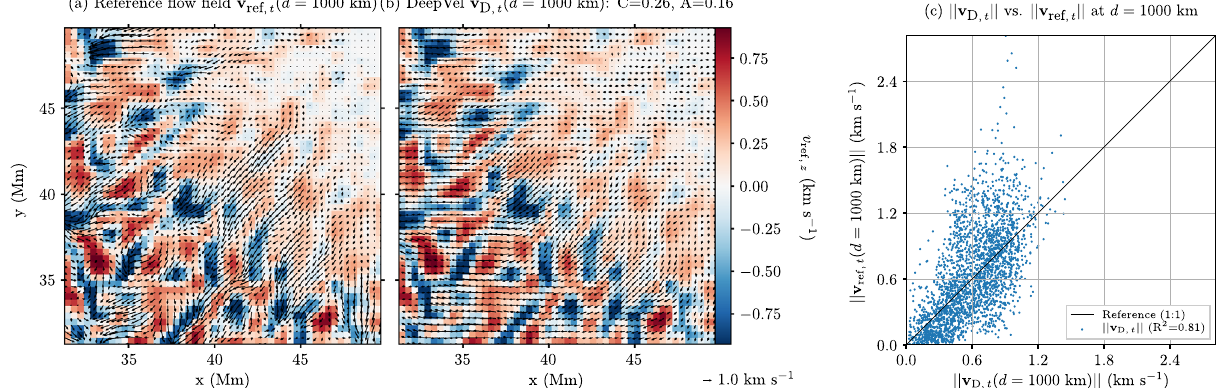
Fig. 6. Below the surface velocity inversions, MURaM-ARs dataset. (a) Patch of 50 by 50 pixels 2 extracted from the 30-min-averaged transverse velocity fi eld v D , t ( d , t i ) inferred by DeepVel at geometrical depth d = 1000 km. The time-averaged vertical velocity v ref, z ( d = 1000 km, t i ) computed by the MURaM-ARs simulation and resampled to the SDO/HMI resolution is displayed as colored background. (Right column) Scatterplot comparing amplitudes || v D , t || to || v ref, t ||. The black line represents the expected solution (i.e., a coef fi cient of determination R 2 =